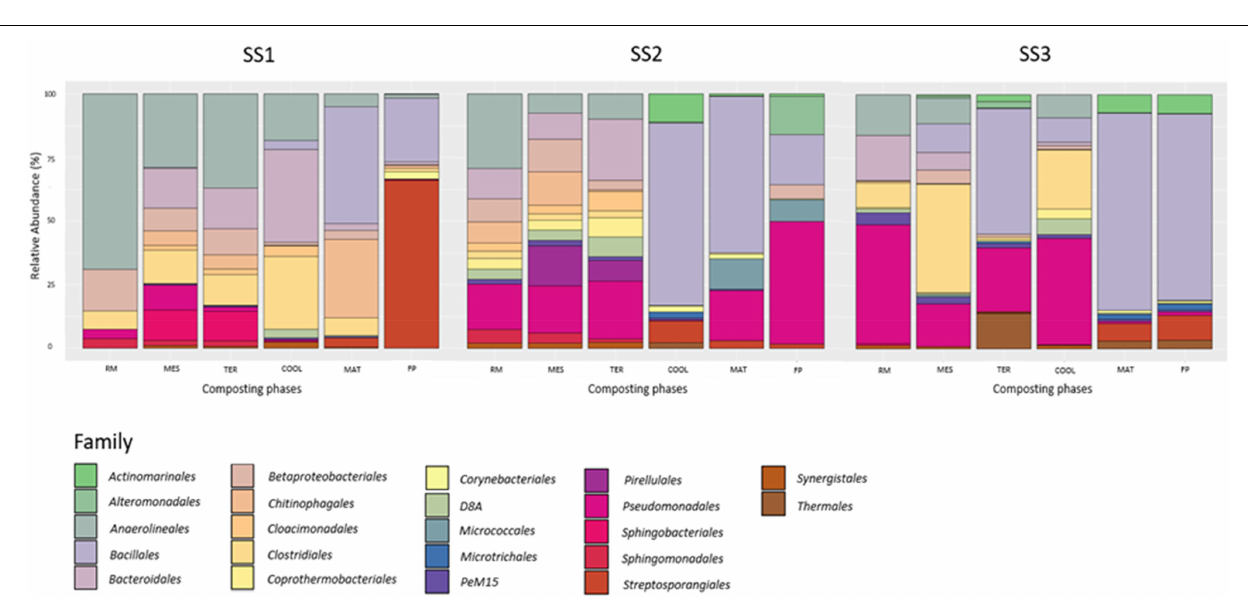
FIGURE 2 | Boxplot of biodiversity indexes (Chao 1 and Shannon). SS1, SS2, and SS3 represent each of the sampled sewage sludge composting facilities.